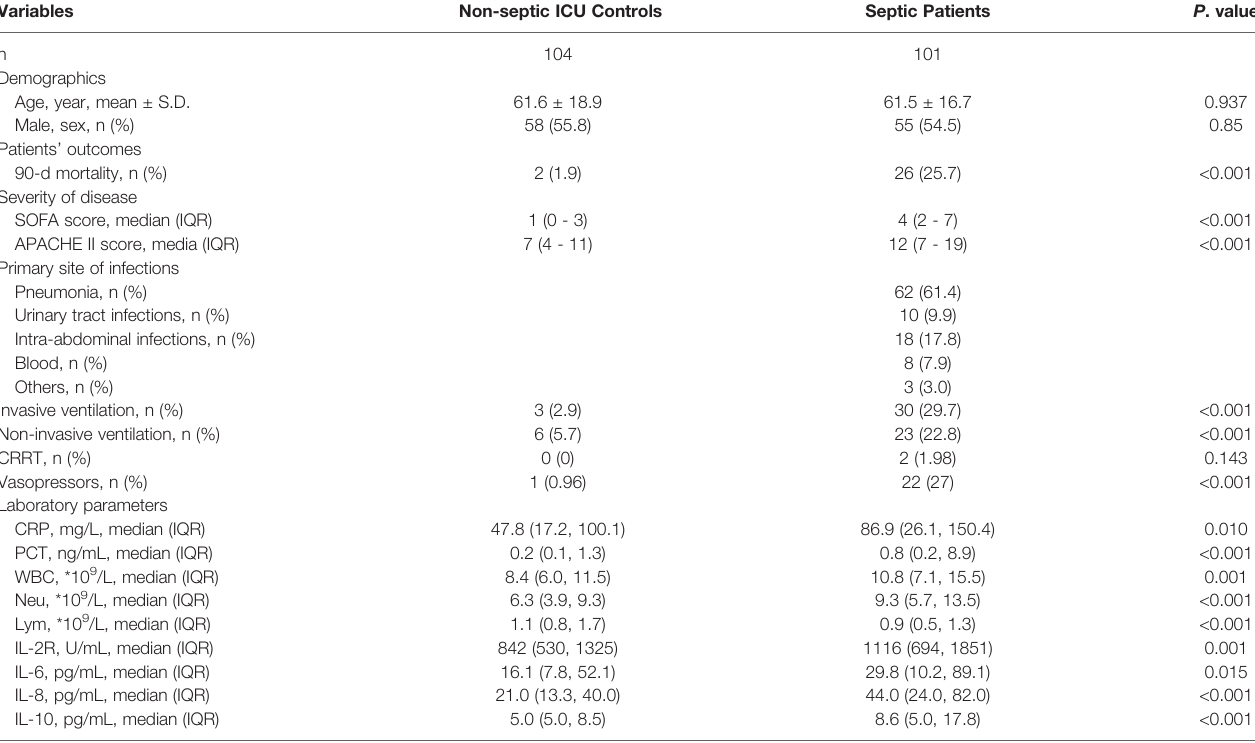
TABLE 1 | Baseline characteristics of patients at ICU admission.